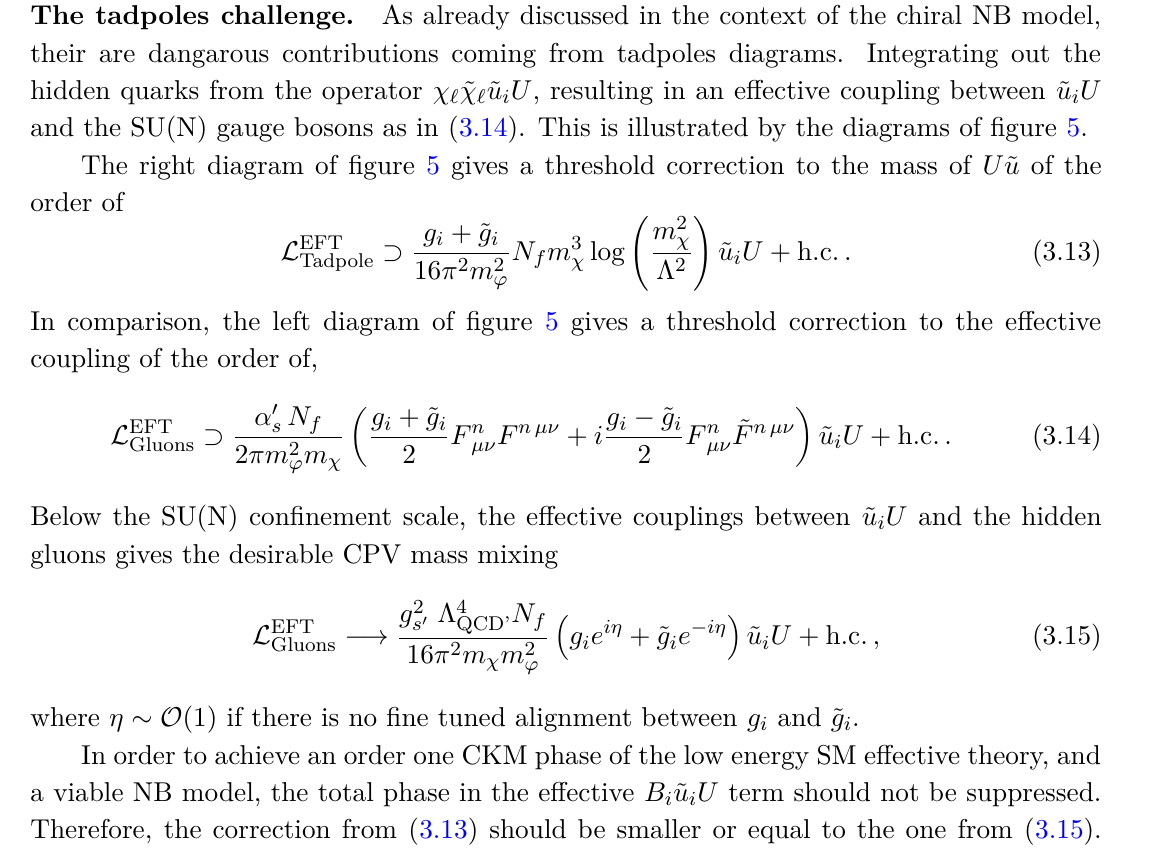
Figure 5 . Left: complex contribution of the gluon condensate to the NB coupling in eq. (3.15). Right: only real contribution to the NB coupling from the